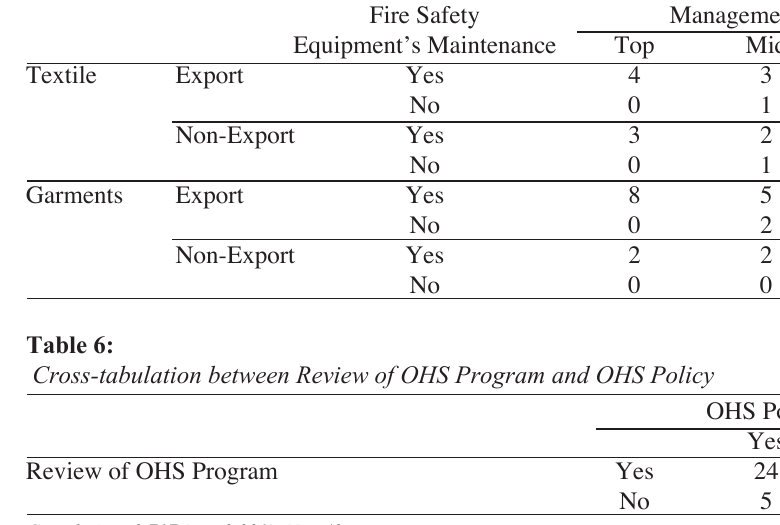
Correlation: 0.717 (p < 0.001); N =